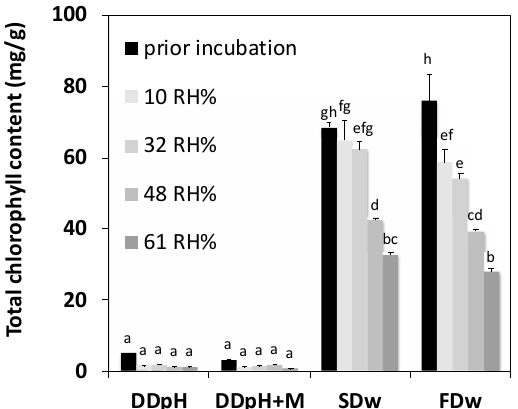
Figure 3. Total chlorophyll content of thylakoid powders produced in di ff erent ways after 8 months storage in controlled atmosphere with di ff erent relative humidity. DD pH = drum-dried powder produced by the pH method, DD pH + M = drum-dried powder produced by the pH method with addition of maltodextrin, SD w = spray-dried powder produced by the water method, FD w = freeze-dried powder produced by the water method. Di ff erent letters indicate significant di ff erence ( p < 0.05).